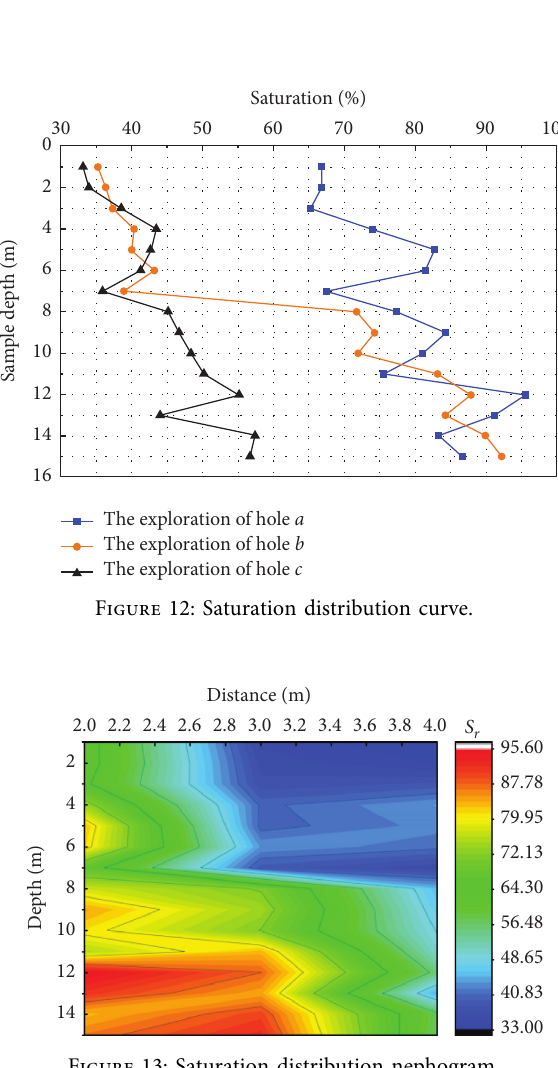
Figure 13: Saturation distribution